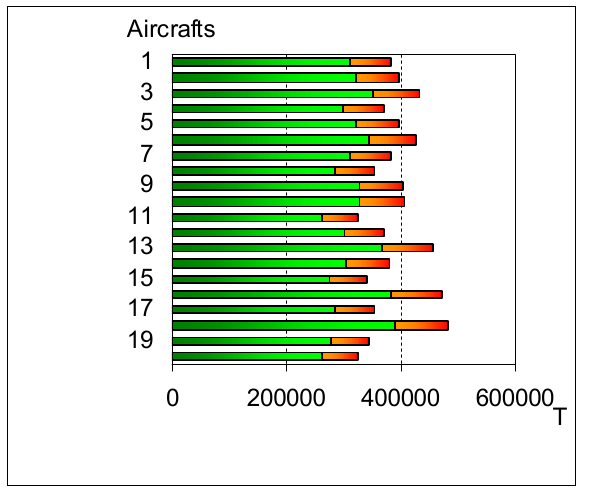
Fig 5. Bar chart of CUCDTP for the non-corroded specimens